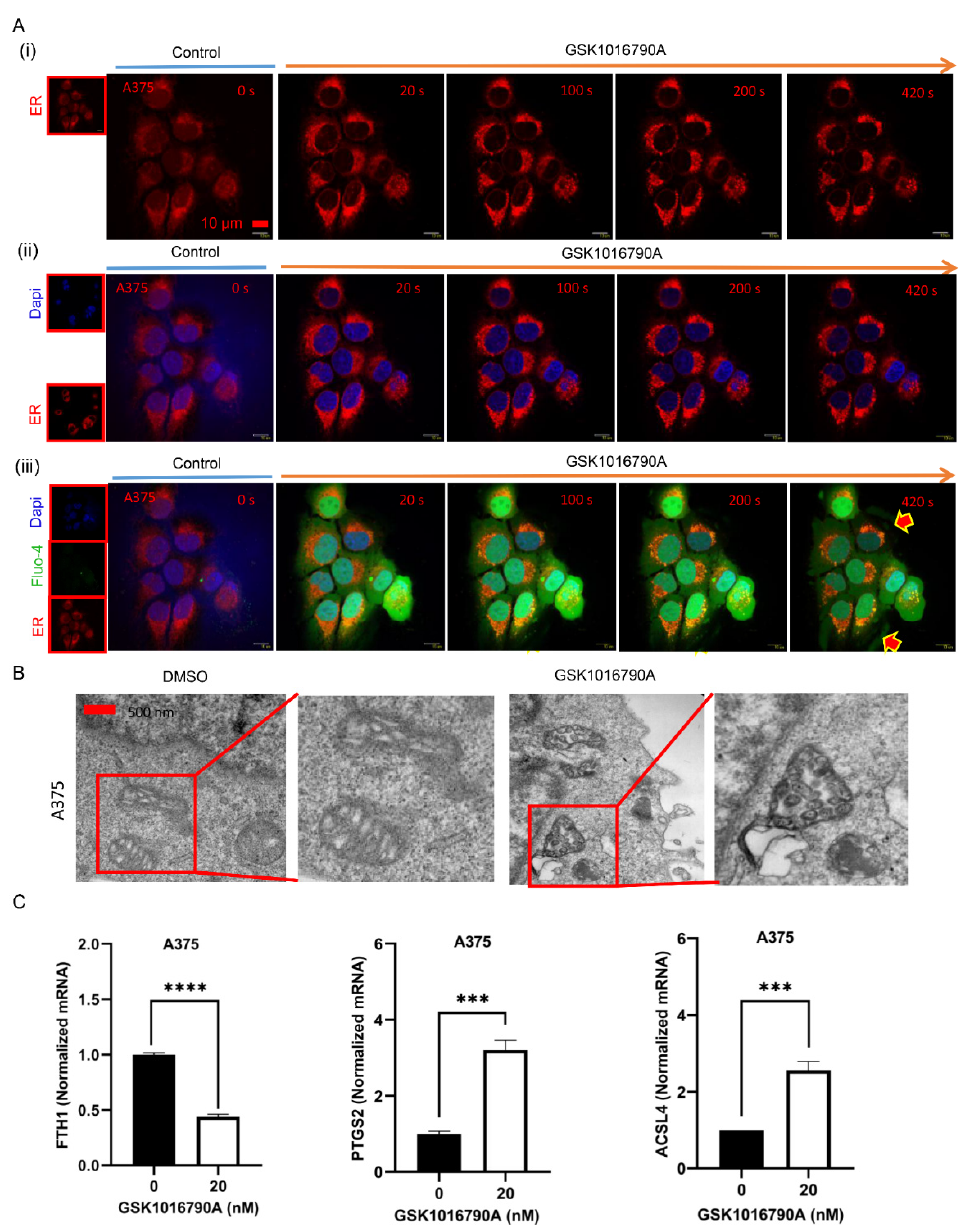
Figure 7. Agonism of TRPV4 induces vesicles priming from ER and subsequently ferroptosis of cells. ( A ) ( i ) & ( ii ) & ( iii ) Time-lapse of scanning disk confocal images of ER staining in A375 cells with GSK1016790A (20 nM) administration. Scale bar, 10 μ m. ( B ) Transmission electron microscopic images of mitochondria in A375 cells incubated with GSK1016790A (20 nM) for 7 min. Scale bar, 500 nm. ( C ) Real-time PCR analysis of FTH1, PTGS2, and ACSL4 mRNA in A375 cells treated with GSK1016790A (20 nM). Data are presented as mean ± SD of at least three independent experiments, t -test, *** p < 0.001, **** p <